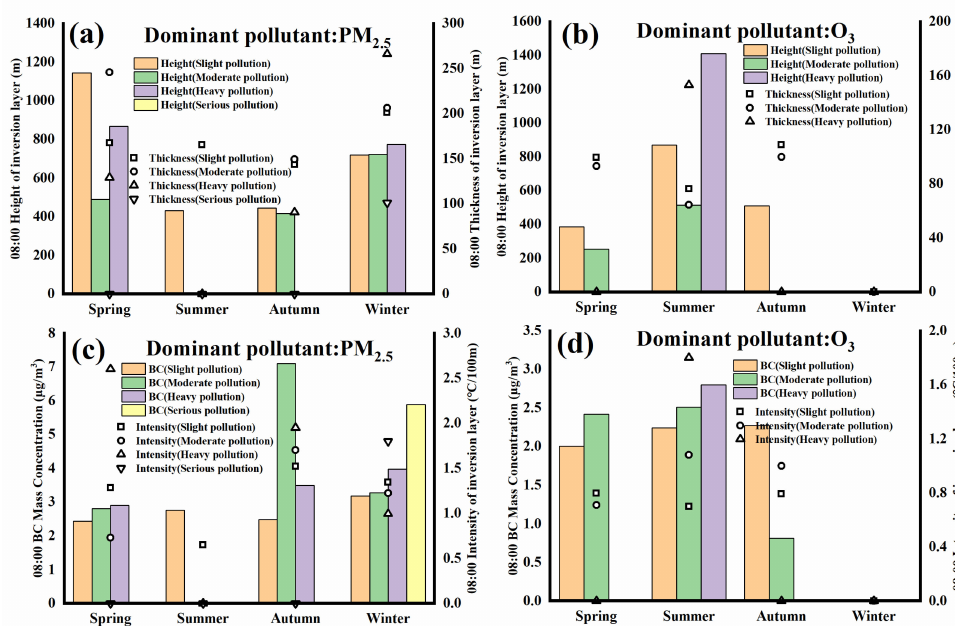
Figure 7. ( a ) Seasonal variations in inversion layer height and inversion layer thickness at 08:00 for the dominant pollutant PM 2.5 at different air quality levels in 2015–2020; ( b ) Seasonal variations in inversion layer height and inversion layer thickness at 08:00 for the dominant pollutant O 3 at different air quality levels in 2015–2020; ( c ) Seasonal variations in BC mass concentration and inversion layer intensity at 08:00 for the dominant pollutant PM 2.5 at different air quality levels in 2015–2020; ( d ) Seasonal variations in BC mass concentration and inversion layer intensity at 08:00 for the dominant pollutant O 3 at different air quality levels in 2015–2020.